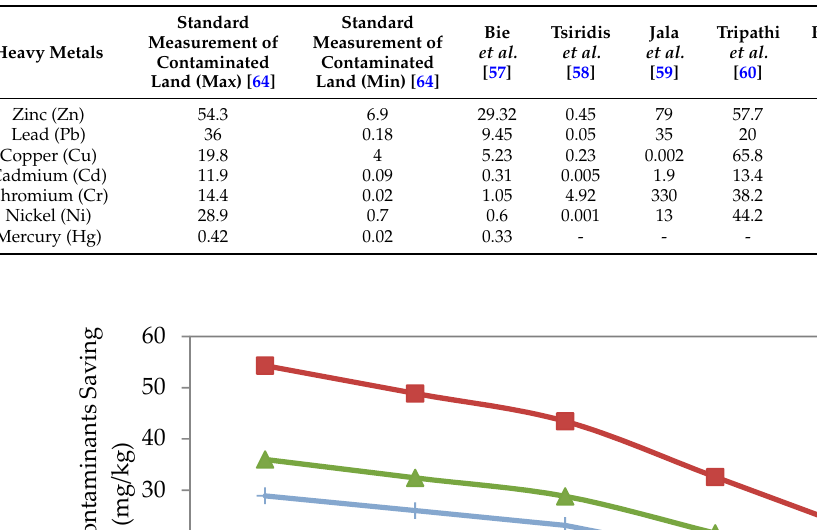
Table 12. Fly ash contaminants in soil.